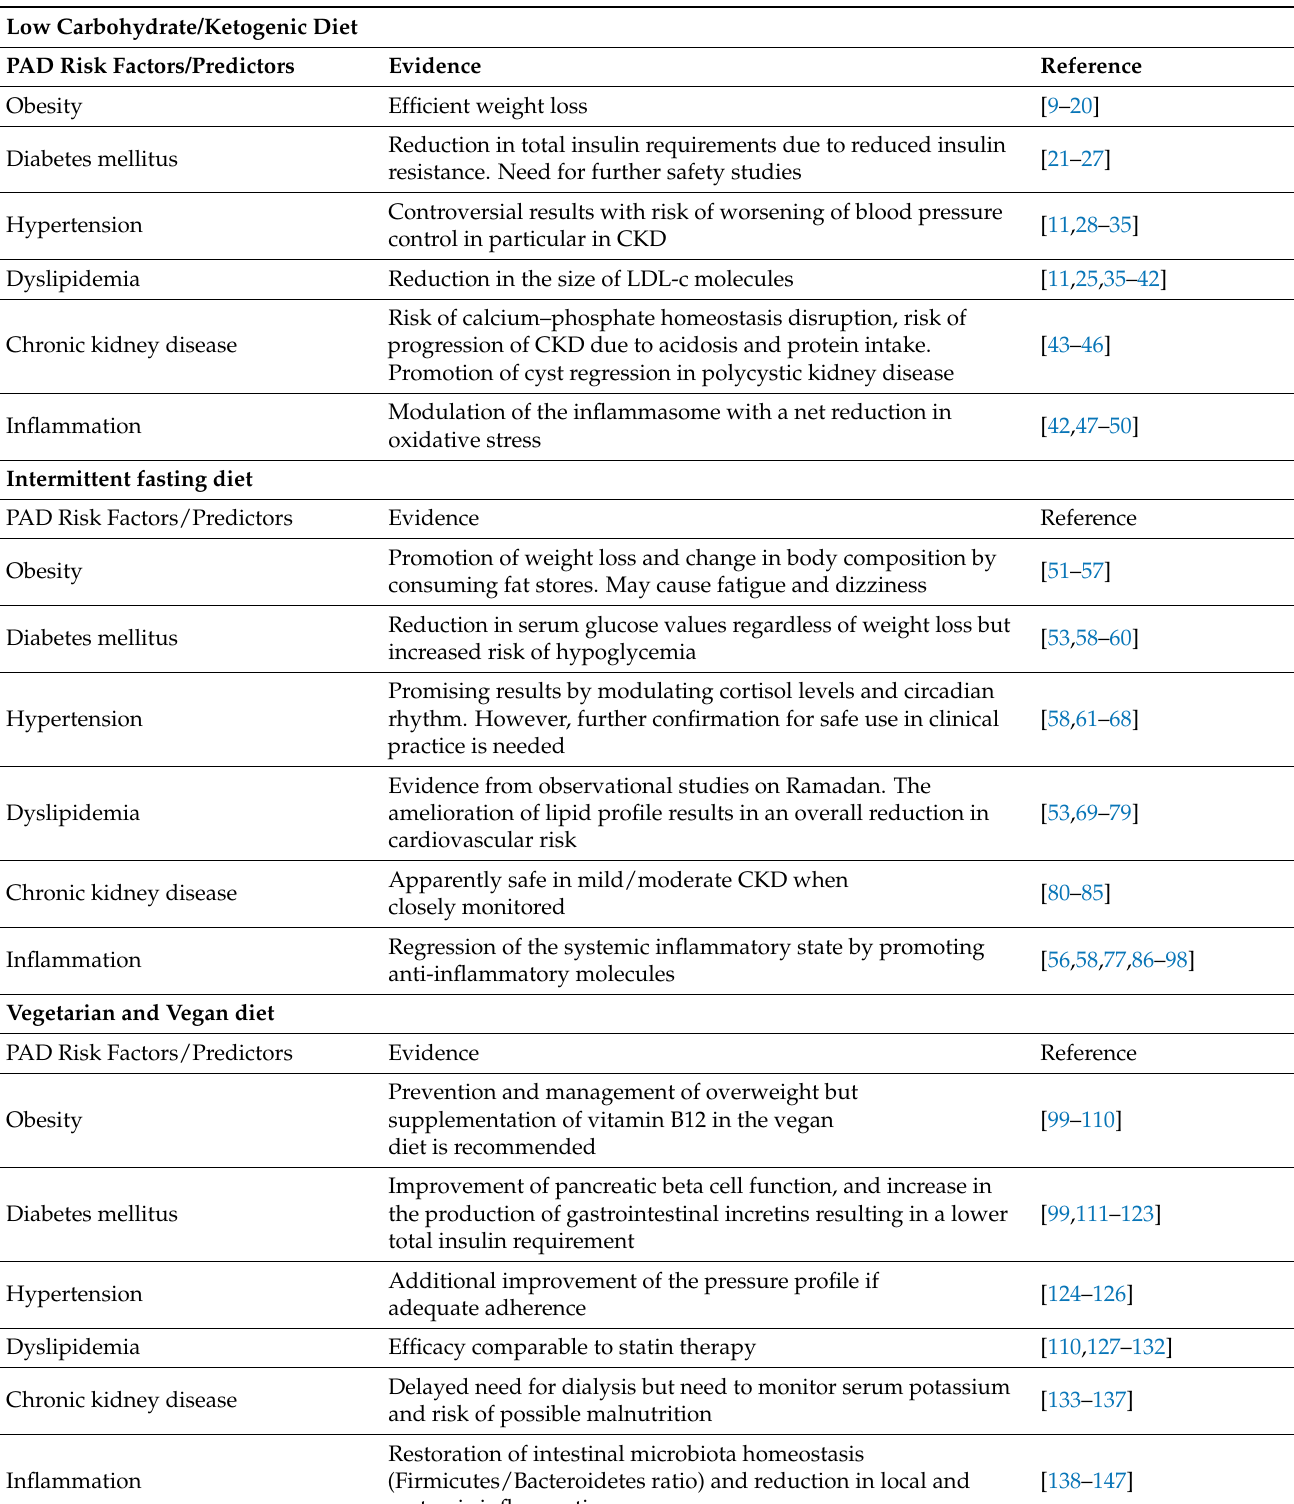
Table 1. Interplay between non-dietary risk factors and predictors of PAD with